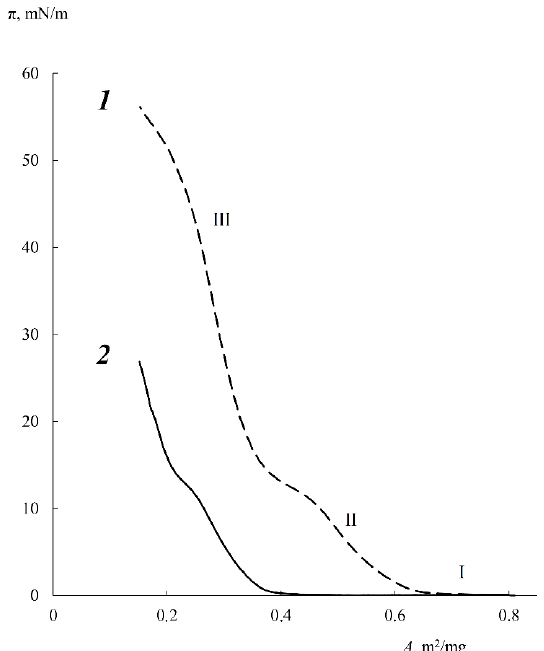
Figure 5. Isotherms of surface pressure π of homopolymer PFMA at pH = 7.0 (1) and 1.3 (2) spread with chloroform/methanol (volume of spreading solution 30 μ L, T = 21 °C). The surface pressure isotherms of the functional polymer PNIPAAm ‒ Ge(C 6 F 5 ) 2 H us- ing a mixture of solvents chloroform/methanol on subphases of different acidity and at different volumes of spreading solutions were obtained also. The curves were compared